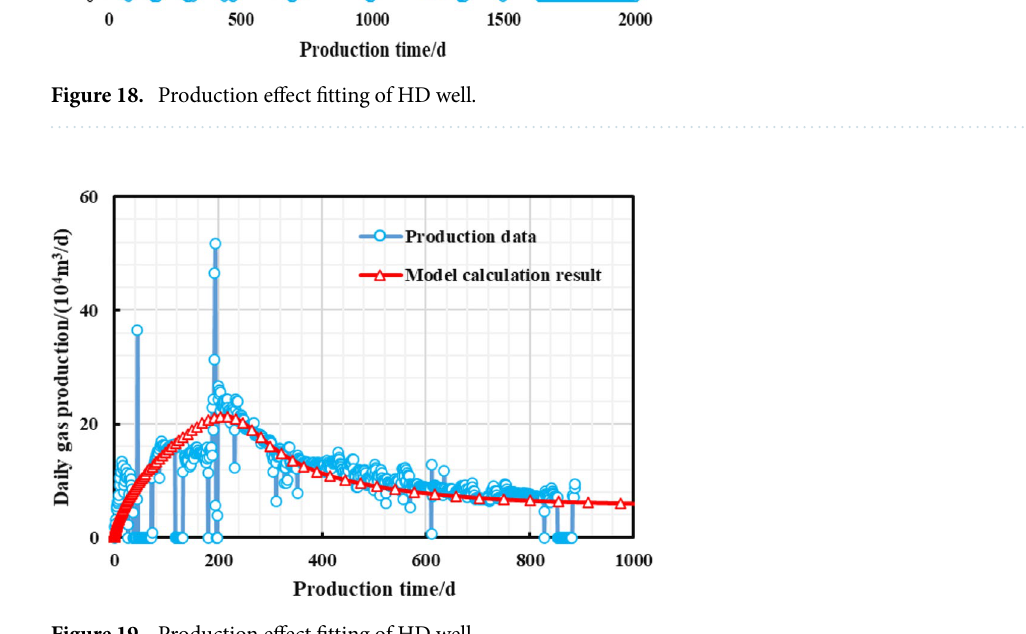
Figure 19. Production effect fitting of HD